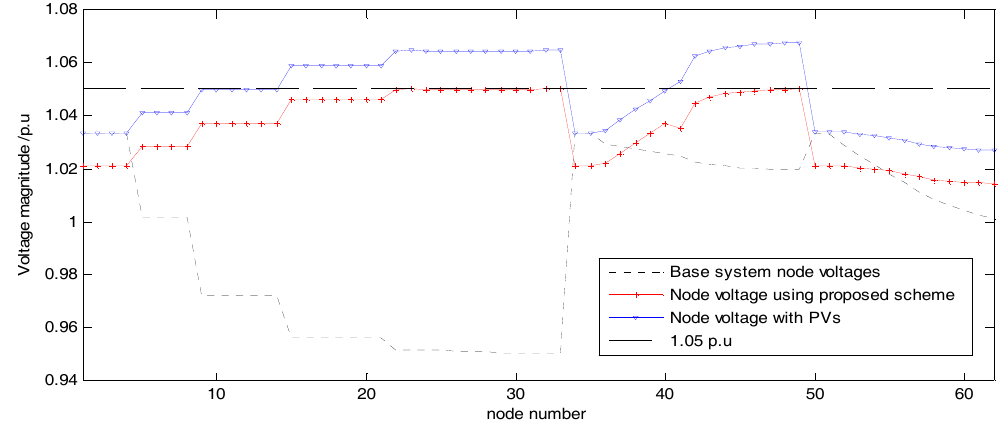
Figure 15. Voltage profiles under different scenarios.